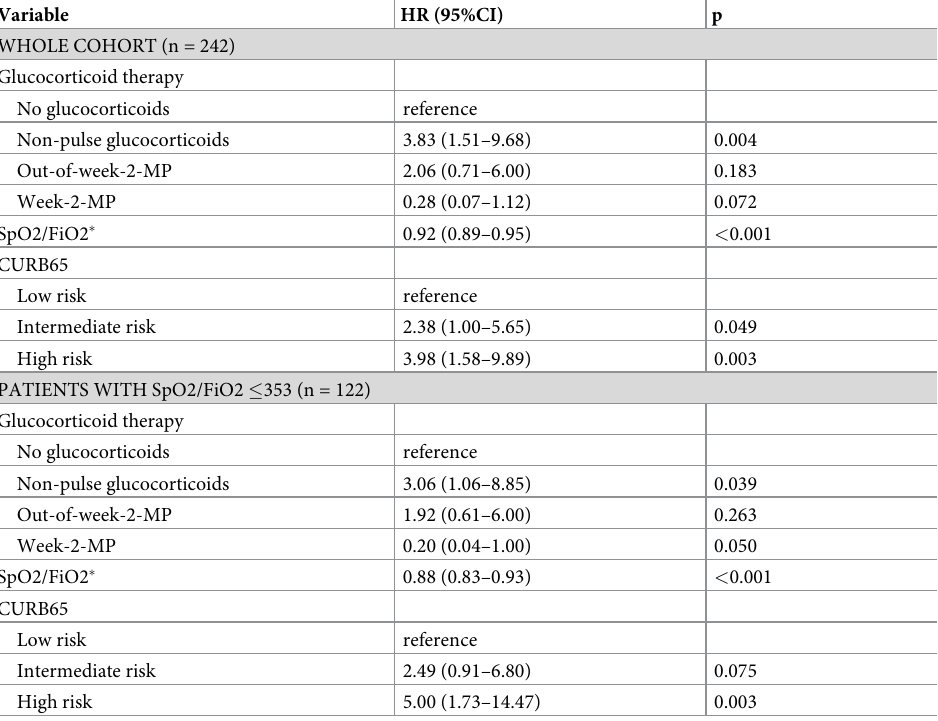
Table 6. Predictors of death or intubation. Final models using the type of glucocorticoid therapy.